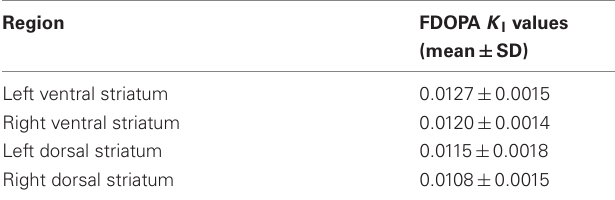
Table 2 | FDOPA K I values in regions of interest.